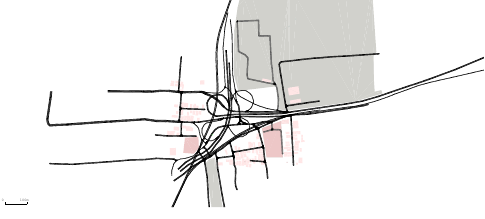
Figure 1. View of Kathipara Junction in Chennai, India, in SUMO